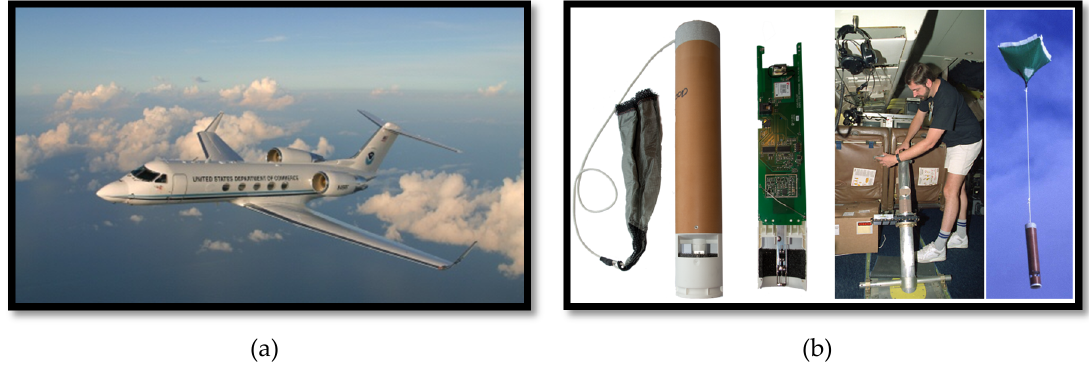
Figure 1. ( a ) Gulfstream IV ‐ SP (G ‐ IV) [96] ; ( b ) GPS Sonde and Launch [97].